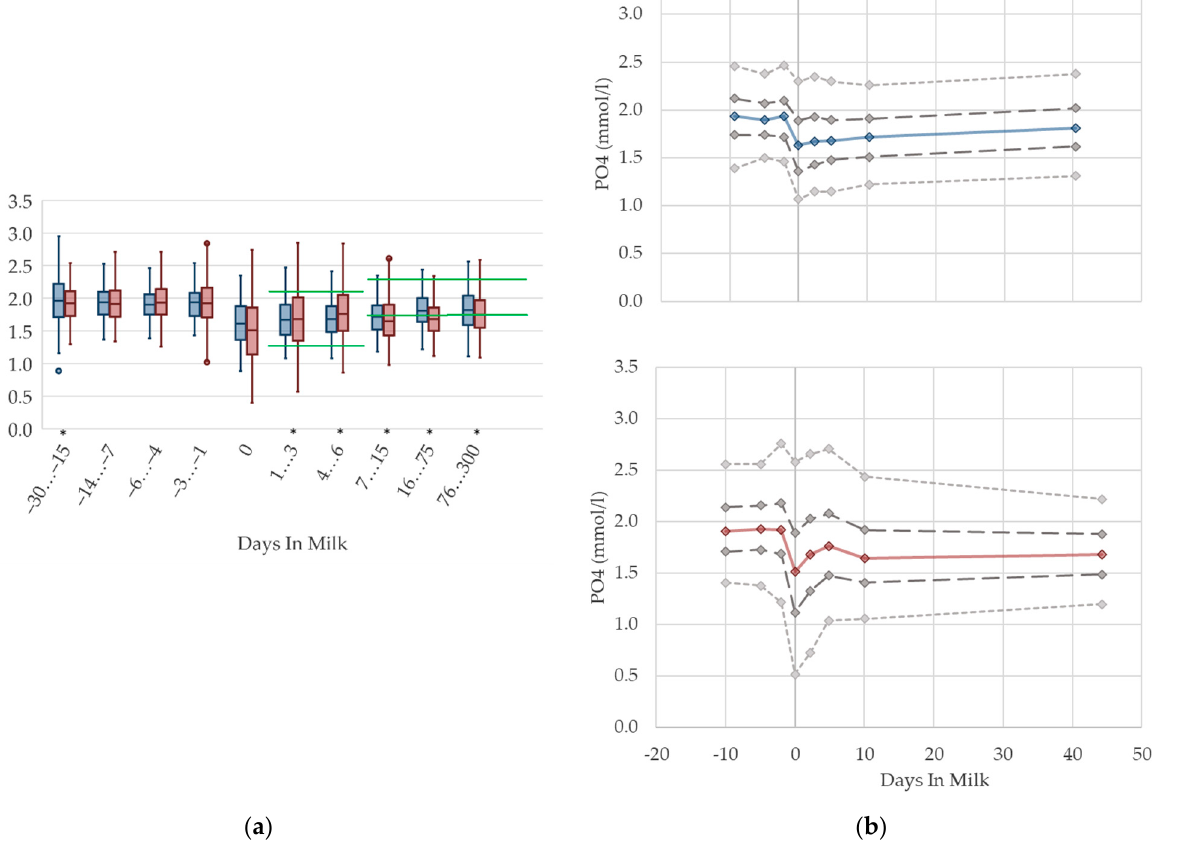
Figure 10. Serum concentrations of phosphorus (PO4) in primiparous (blue) and in multiparous (red) cows ( a ) in 10 classes between 30 days prepartum to 300 days postpartum (boxplots), green continuous lines represent the reference values according to Fürll [23], asterisk indicates significant differences regarding parity within DIM class; and ( b ) in 8 classes from 10 days prepartum to 40 days postpartum (median—continuous line; 1st and 3rd quartile—dashed lines; percentile 5 and 95—dotted lines).